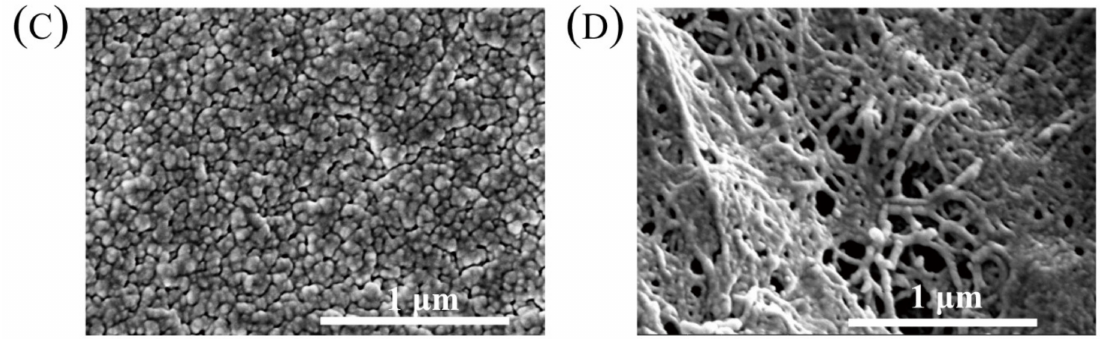
Figure 2. ( A ) TEM image of CAP in water and ( B ) particle size profile; SEM microscopic images of ( C ) AG and ( D ) CAG.